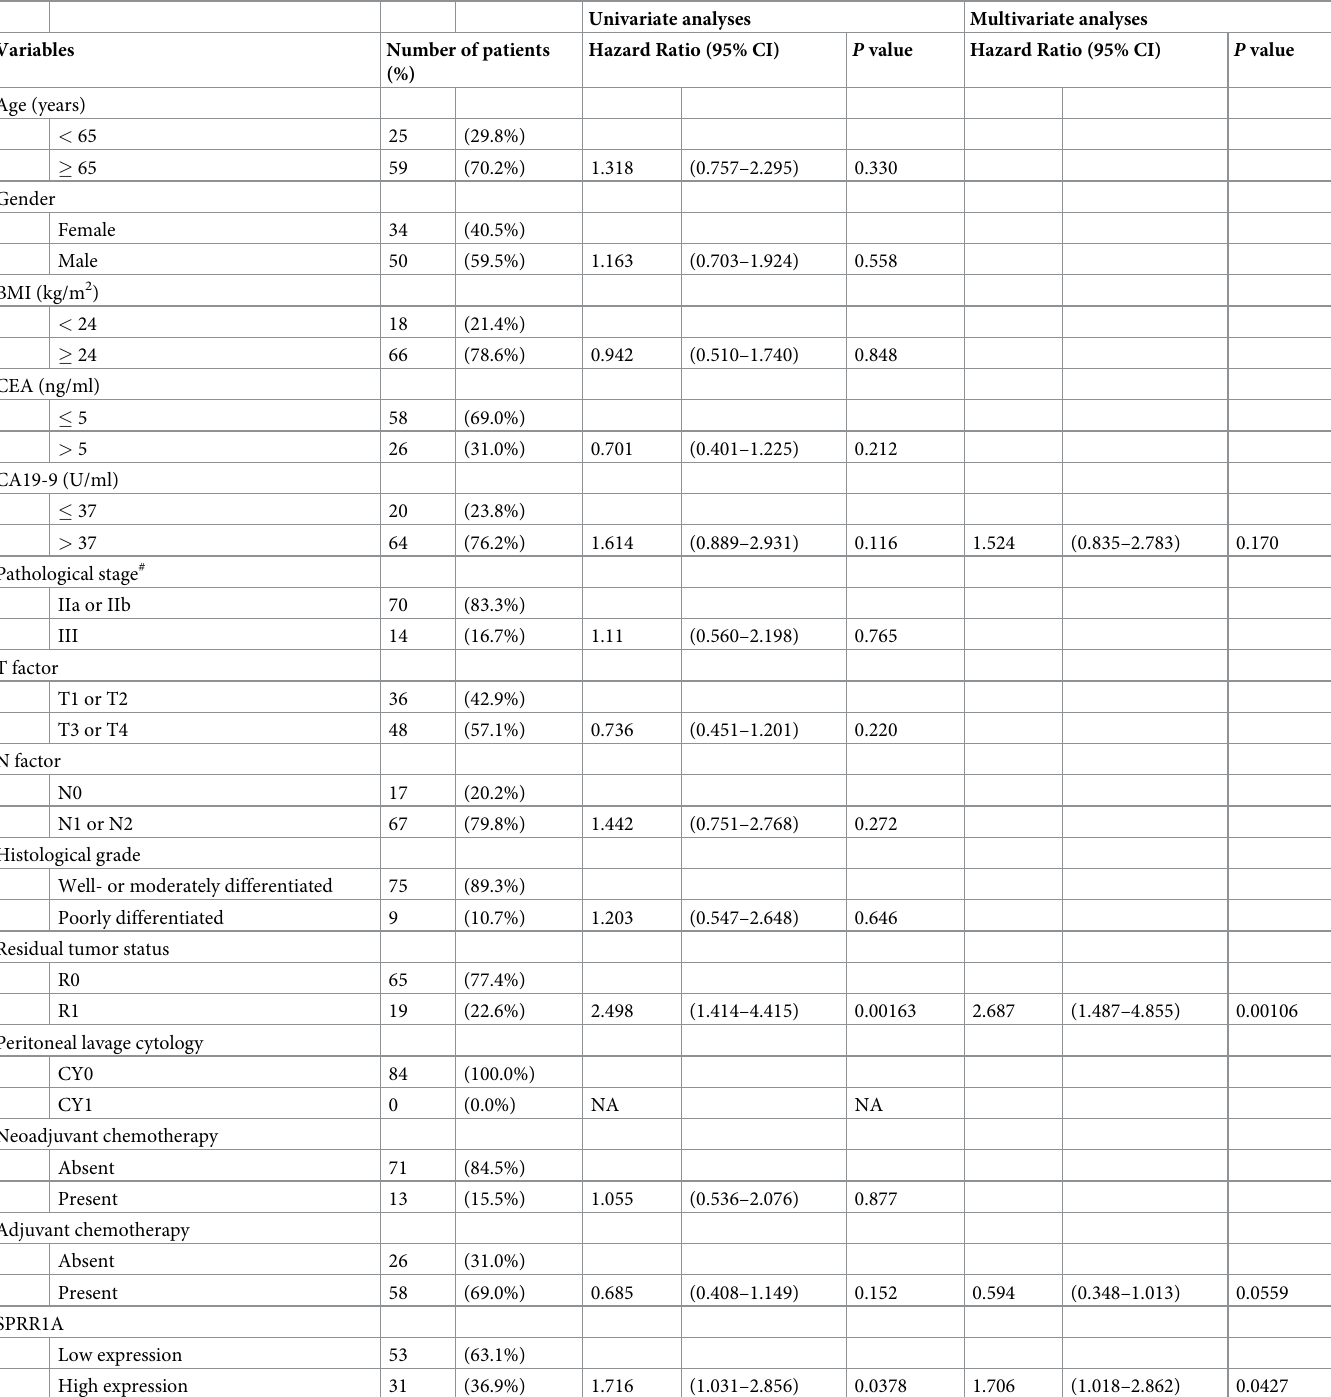
Table 2. Univariate and multivariate analyses of the overall survival time in patients with pancreatic